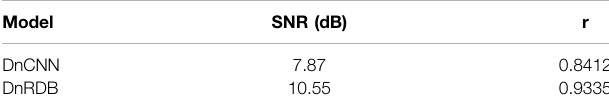
TABLE 1 | Five-fold cross-validation average results of the two